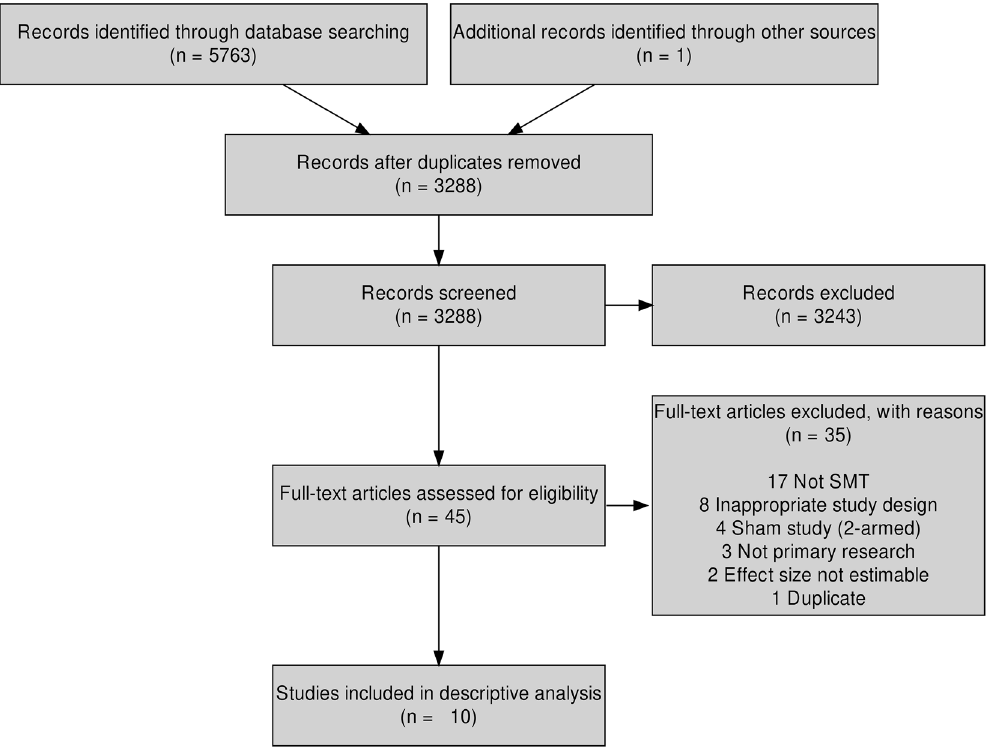
Figure 1. PRISMA flow diagram of the literature search and study inclusion in a systematic review comparing the outcome of applying spinal manipulative therapy at a candidate site versus a non-candidate